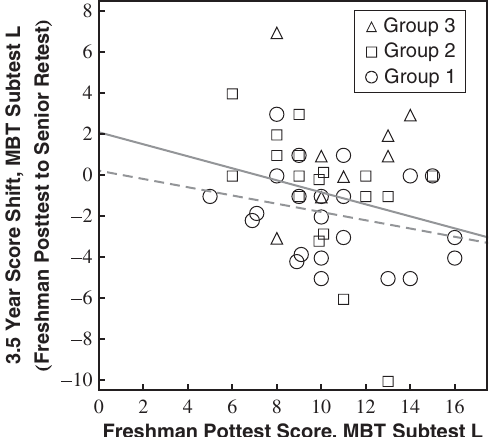
FIG. 5. Score shift from the end of freshman mechanics to graduation on subtest L of the MBT versus the score achieved on subtest L at the end of the freshman course. The solid line fits the data for all groups of students, the dashed line fits the group 1 data only.